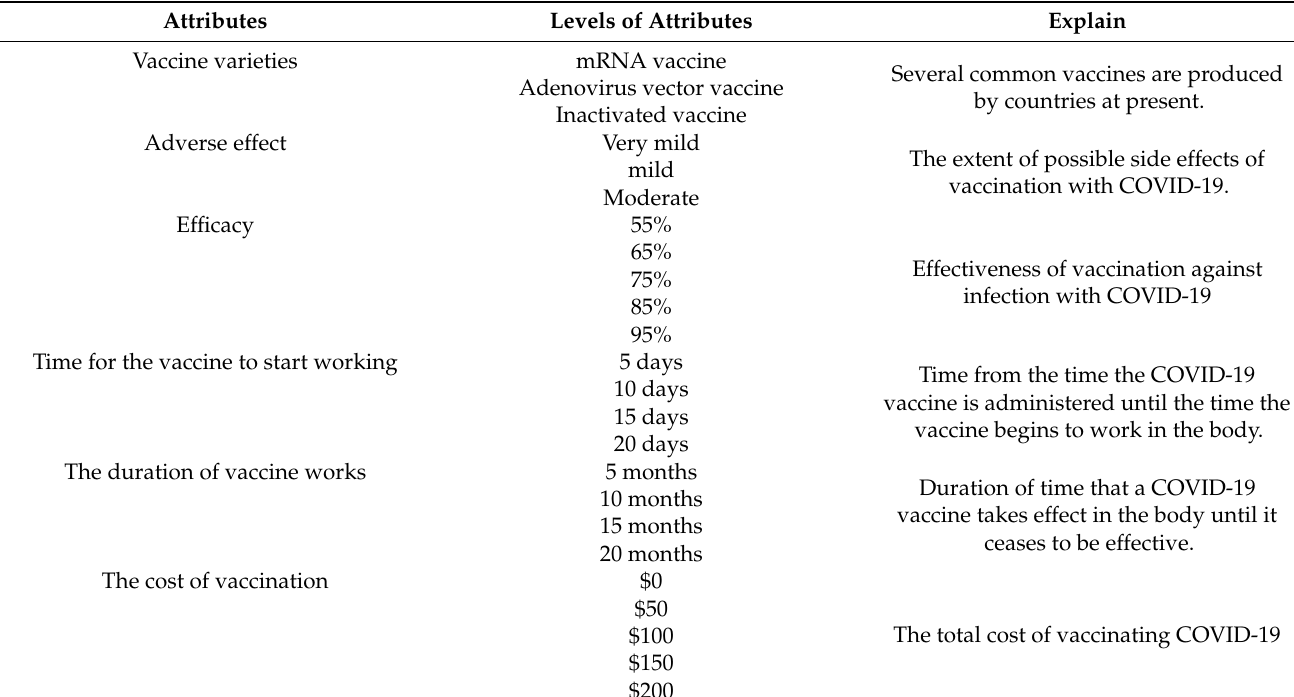
Table 1. Vaccination of attributes and their respective levels in this discrete choice experiment. Attributes Levels of Attributes Explain Vaccine varieties mRNA vaccine Several common vaccines are produced present.Adenovirus vector vaccine by countries at Inactivated vaccine Adverse effect Very mild The extent of possible side effects of COVID-19.mild vaccination with Moderate Effectiveness of vaccination